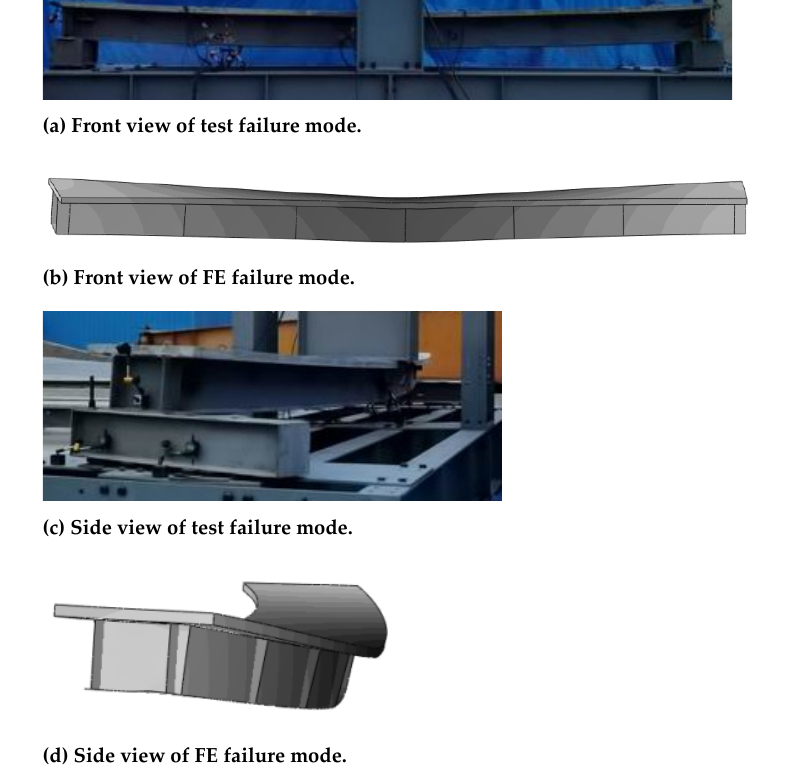
Figure 16. Comparison of the failure modes from the test and finite element analyses of CCB-2.